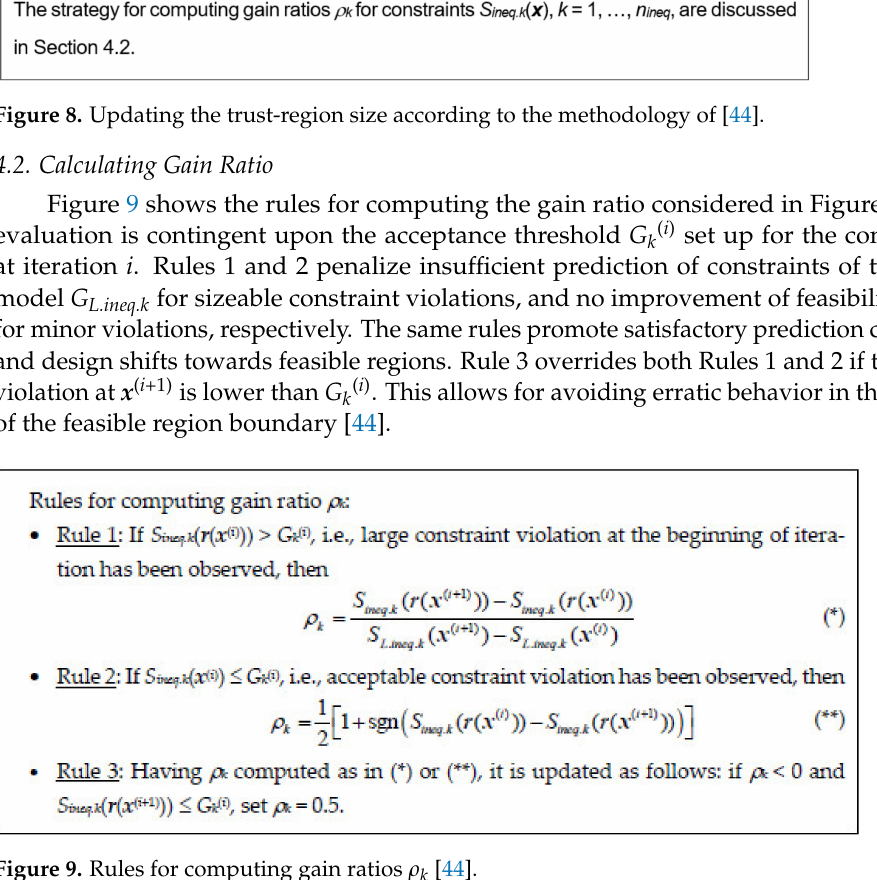
Figure 9. Rules for computing gain ratios ρ k